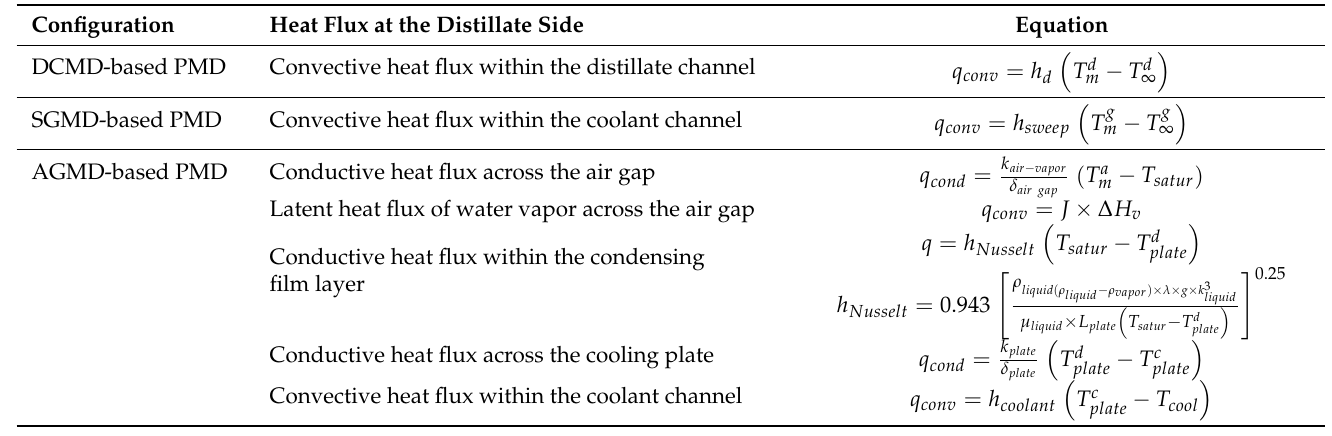
Table 3. Heat transfer at the distillate side for different PMD configurations. Reproduced with permission from Ref. [43]. Copyright 2022 Royal Society of Chemistry.